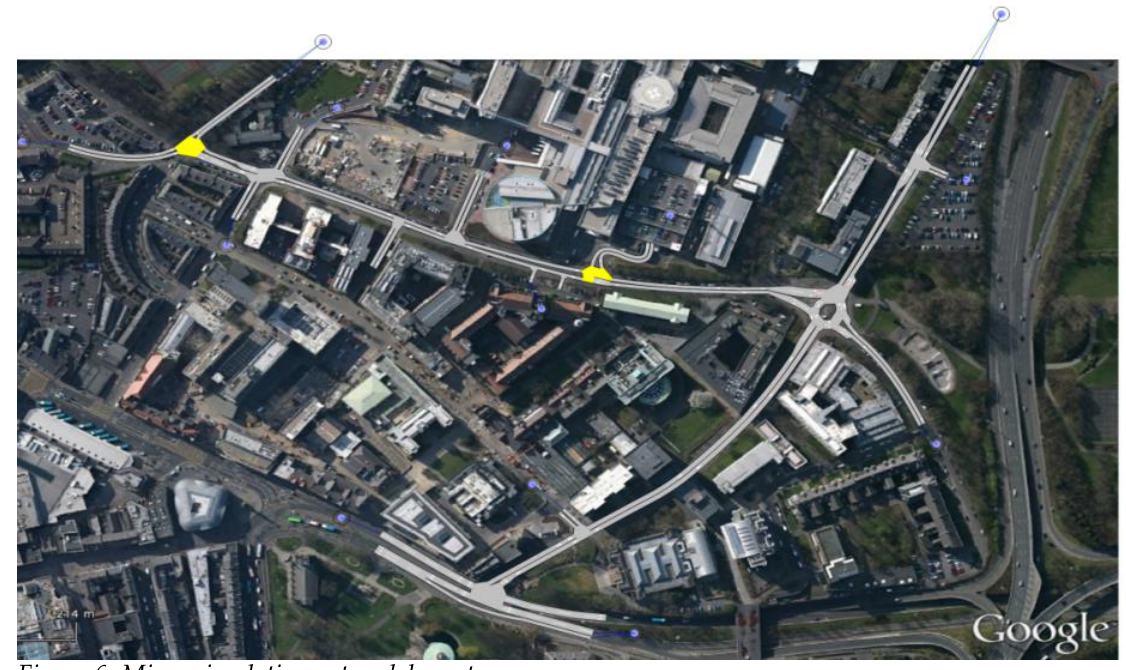
Figure 6. Micro-simulation network